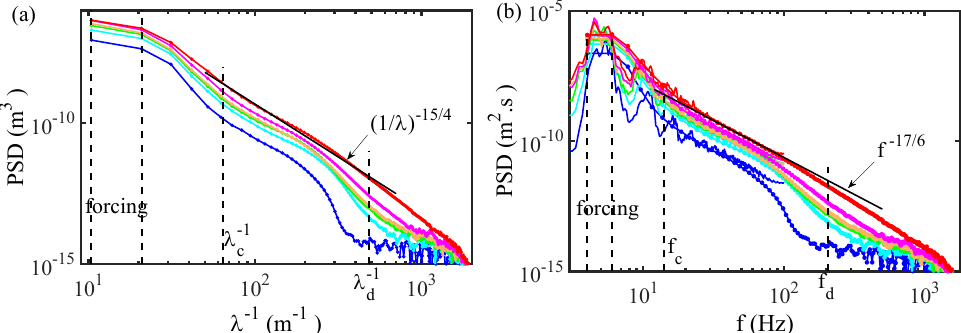
Figure 16. ( a ) Spatial power spectra S η ( k ) (power spectrum density—PSD) for different forcing amplitudes. From bottom to top: σ h = 1.3, 2.1, 2.7, 3.1, 3.4, and 3.6 mm, and σ s = 0.15, 0.19, 0.24, 0.27, (cid:112) γ / ( ρ g ) ≈ 15.5mm is the 0.29, and 0.34. Solid black line is the capillary prediction k − 15/4 . λ c = 2 π crossover scale between gravity and capillary waves. λ d ≈ 2.1mm is, approximately for the highest amplitude, the dissipative scale; below it, viscous dissipation dominates nonlinear interactions. ( b ) Temporal power spectra S η ( ω ) for the same measurements. Solid black line is the capillary prediction f − 17/6 . f c = 14.2Hz and f d ≈ 204Hz are the equivalent of λ c and λ d in the frequency space. Two estimates of the frequency spectrum are shown, the first by integration over the wave- numbers of S η ( ω , k ) (continuous curves) and the second by converting the spatial spectrum in the frequency space (dot curve) using the linear dispersion relation (19). (Reprinted with permission from [71] Copyright 2022 Cambridge University